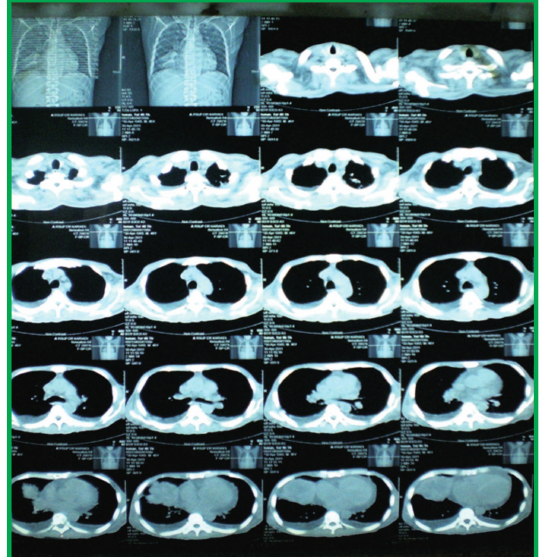
Figure 1. CT scan show a mass in S 4-5 of the right lung and multiple nodul in the liver.